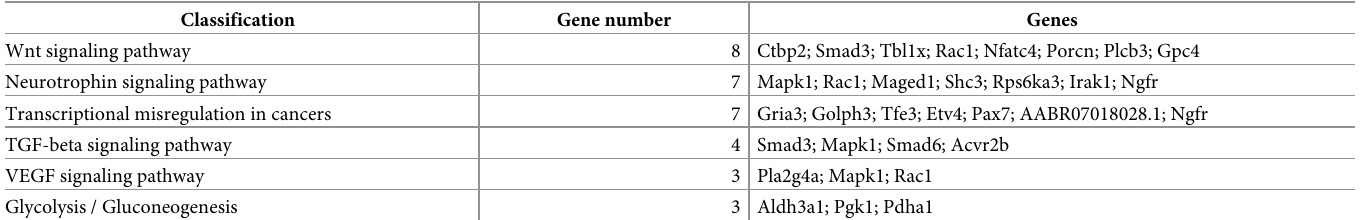
Table 4. Diabetic-vs-control-CCGG.Diff.KEGG-classification.